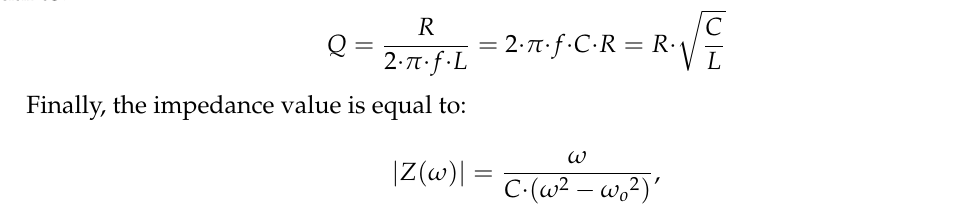
Figure 9 . Resonant filter impedance values.